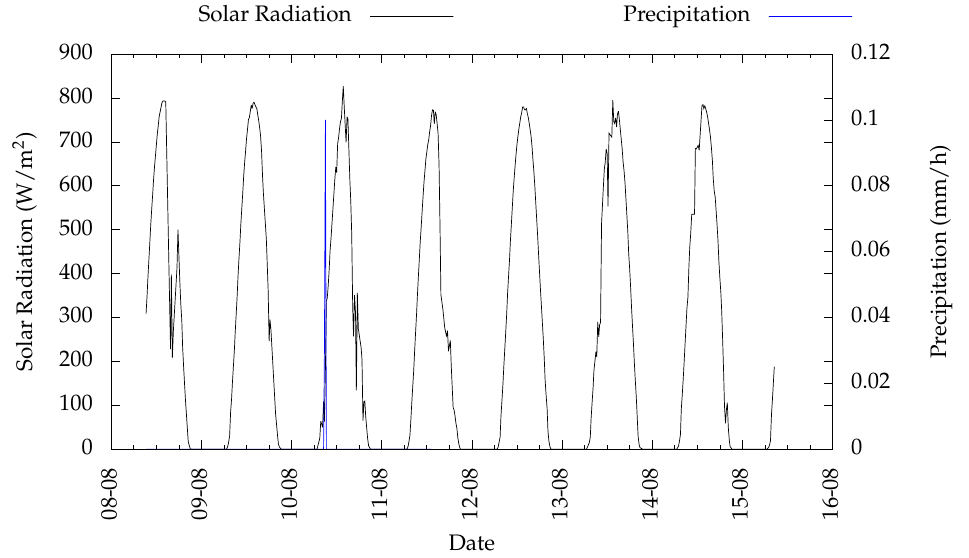
Figure 9. Solar radiation data from ATMOS41.